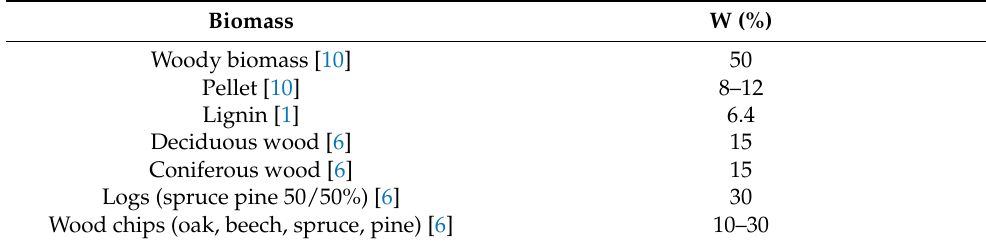
Table 3. Humidity values for